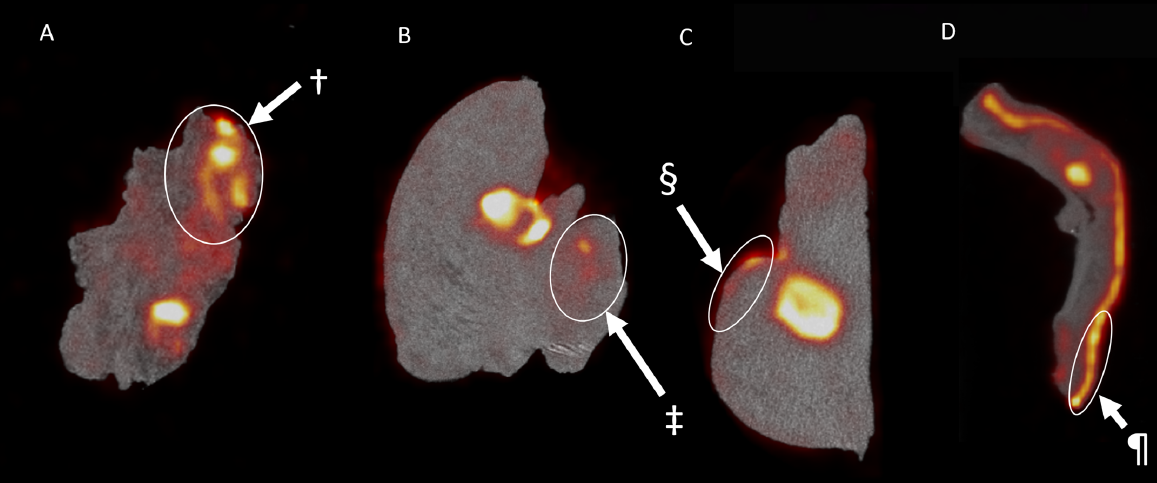
Figure 3. The 18 F-FDG uptake in pathologically proven non-malignant regions. The images display regions of increased 18 F-FDG uptake that were later pathologically proven to be non-malignant tissue. ( A ) displays the coronal view of the resected squamous cell carcinoma (SCC) of the floor of mouth in patient 1. Here, we see an increased uptake in a large region that was later shown to be highly active non-malignant inflamed tissue (†). ( B , C ) display the coronal and sagittal view, respectively, of the hemiglossectomy for a mucosal SCC in patient 2. Here, we see an increased uptake of a salivary gland (‡) and premalignant dysplastic tissue on the tongue’s epithelia (§). ( D ) displays the imaging results found after imaging a nasal resection specimen for an angiosarcoma of the nasal tip in patient 6. Here, ¶ displays an increased uptake in the subcutaneous nasal sebaceous glands.